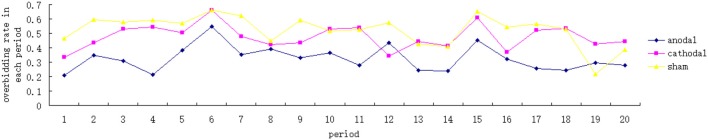
Overbidding rate in each period across the three conditions.